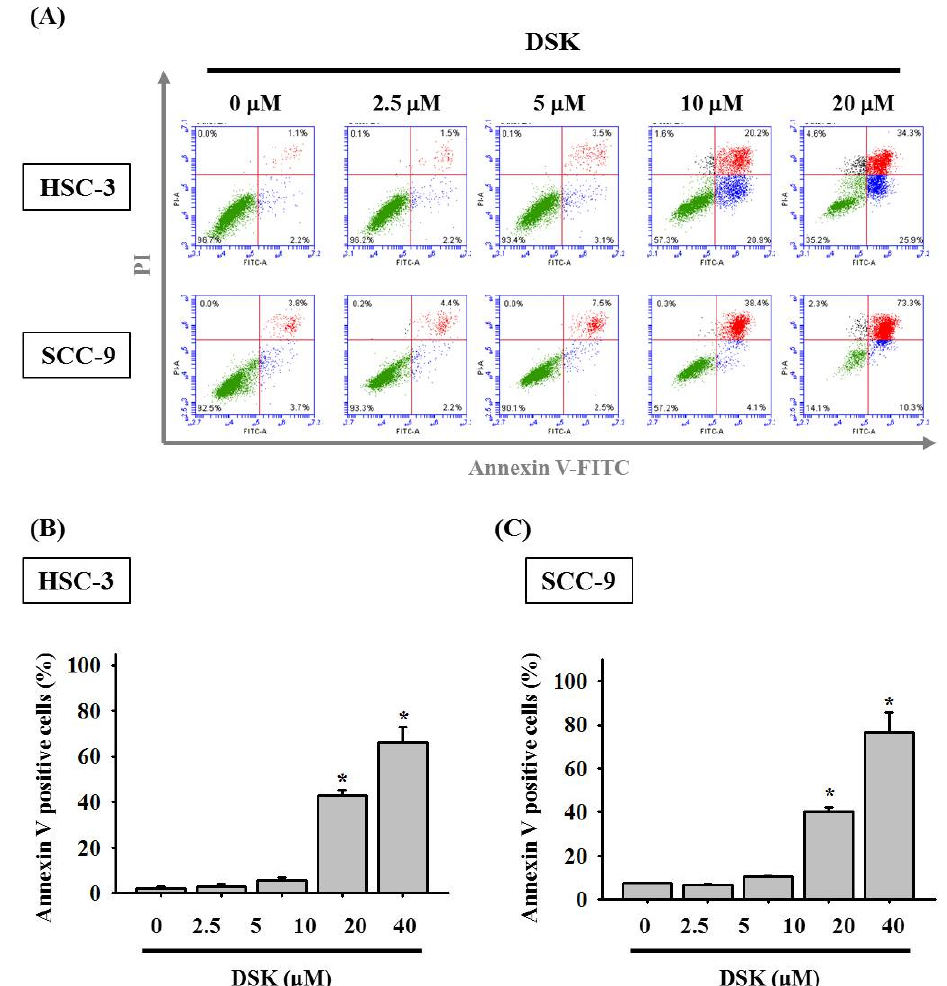
Figure 3. DSK promotes apoptotic responses of tongue cancer. ( A ) Double staining of PI and annexin V in tongue cancer cells after the treatment of DSK at different concentrations for 24 h was analyzed by flow cytometry. Data are representative of three separate experiments. ( B , C ) Quantification of apoptotic cell populations as determined by annexin-V-positive cells in HSC-3 and SCC-9 cells. Data represent the average ± SD of three independent experiments. * p < 0.05 compared with untreated controls using Student’s t -test.